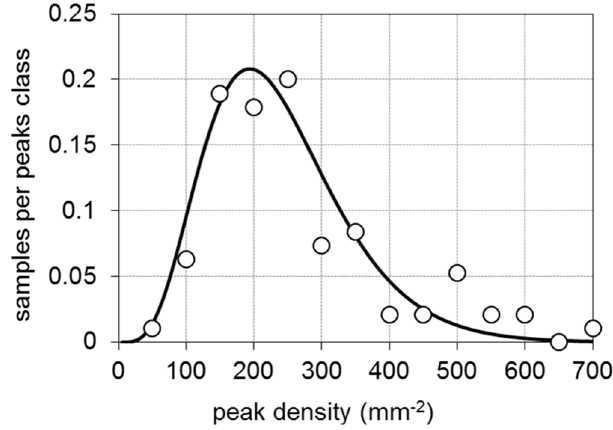
Figure 13. Peak (i.e., nodular defect) density distribution for TiN hard coatings prepared by low-voltage electron beam evaporation (BAI).